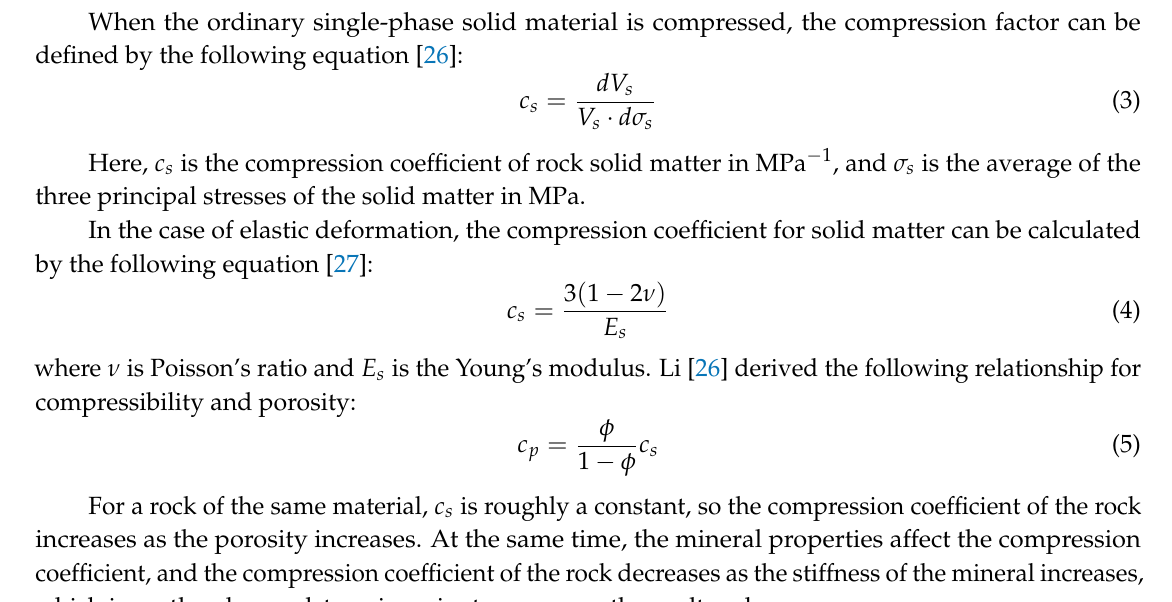
Figure 6. The compressibility × porosity chart from Hall [25].